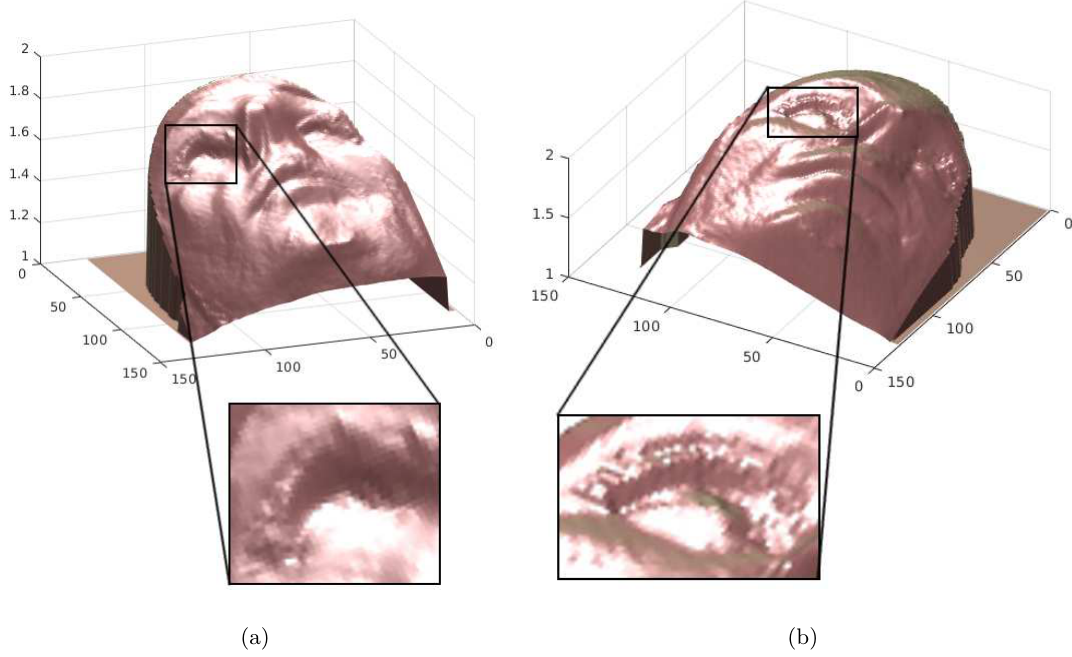
Fig. 17 Depth reconstructions from real world images. (a) Results of our proposed method using the Blinn–Phong model. (b) Results using the method of Ref. [30]. As noted in Ref. [30], they could not obtain the 3D reconstruction in the presence of eyes (due to the specularities) unlike our approach which provides faithful results even with including